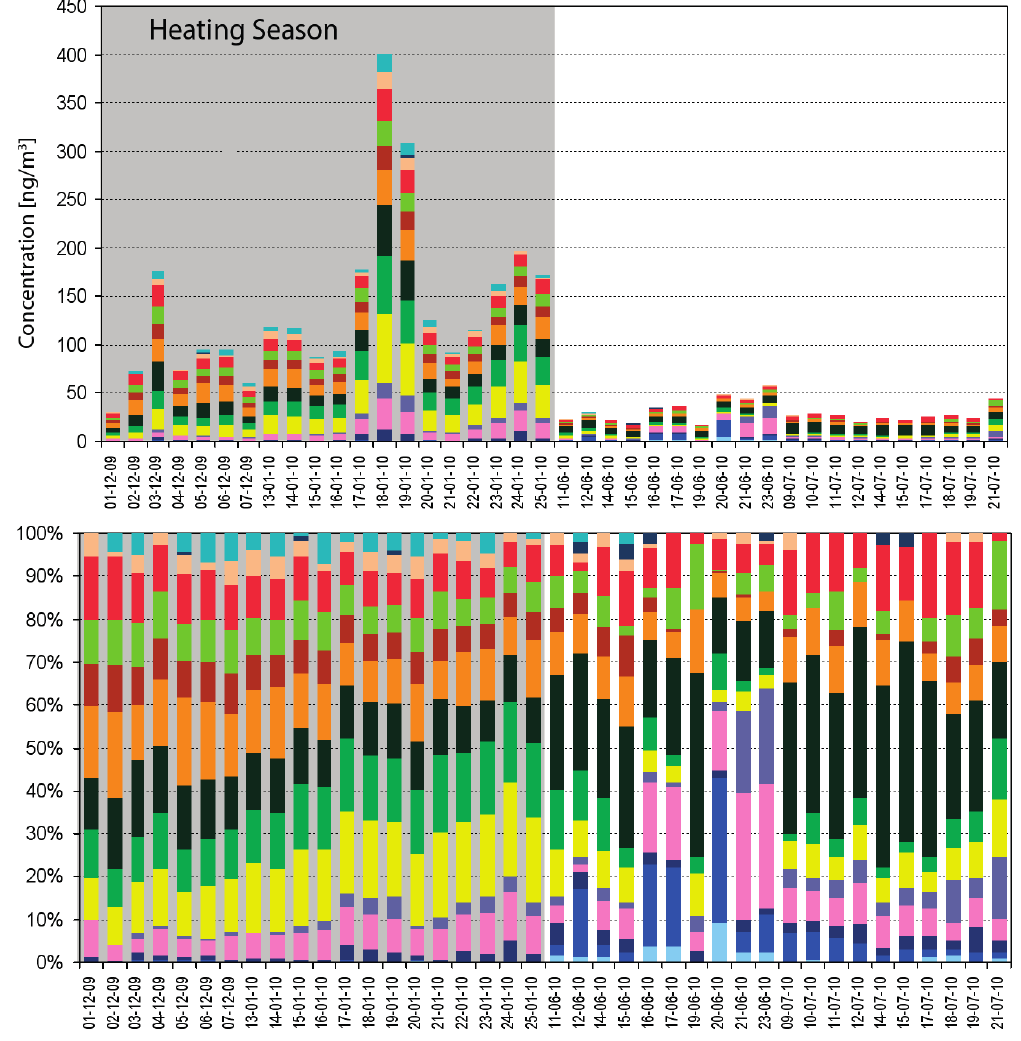
Figure 3. Twenty-four-hour concentrations of 16 PAHs contained in PM 1 and percentages of specific PAHs in the PAH sum at the urban background point